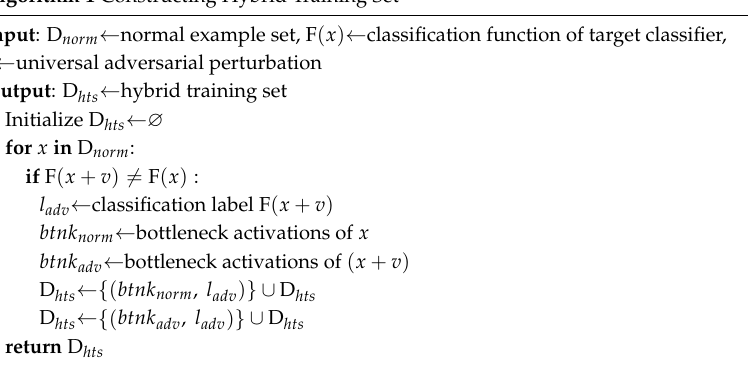
Algorithm 1 Constructing Hybrid Training